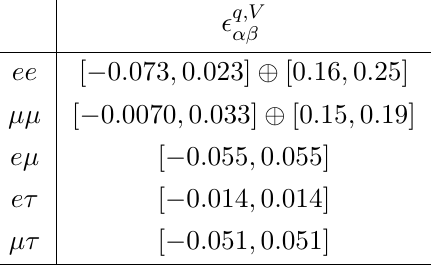
Table 2 . One at a time constraints at 90% C.L. from COHERENT alone for NSI with a heavy mediator assuming that (cid:15) u = (cid:15) d